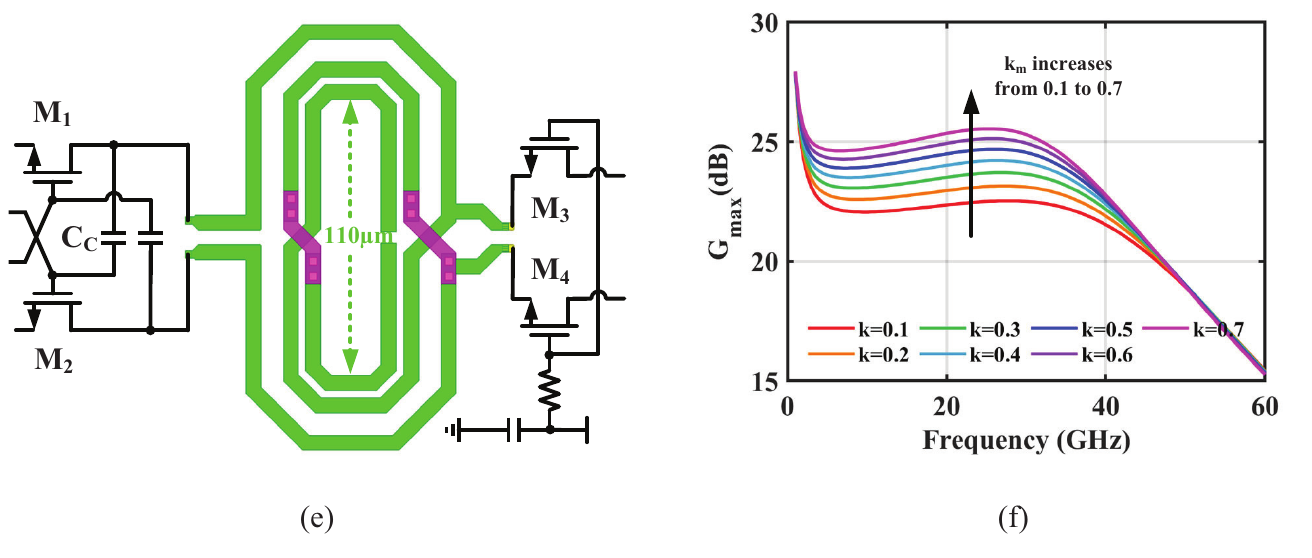
Figure 4. ( a ) cascode LNA with series inductor. ( b ) cascode LNA with parallel inductor. ( c ) cascode LNA with T-coil-based network. ( d ) differential cascode LNA with T-coil-based network. ( e ) 3D view of the differential T-coil-based network ( f ) G max of the first stage varies with different km.